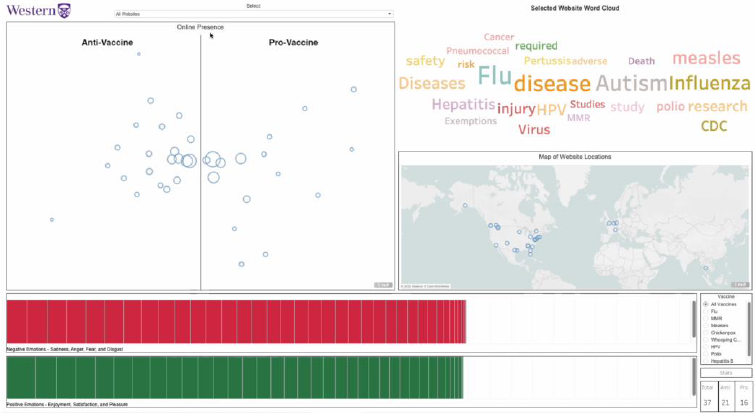
Figure 10. VINCENT, a VAS for